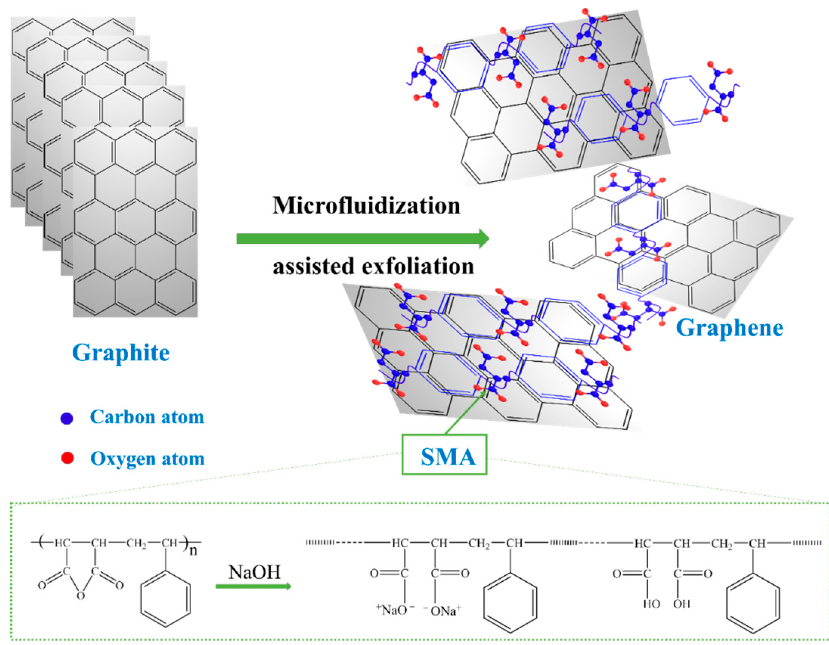
Figure 1. Illustration of graphite exfoliation to graphene using the technique of styrene-maleic anhydride (SMA)-assisted microfluidization.